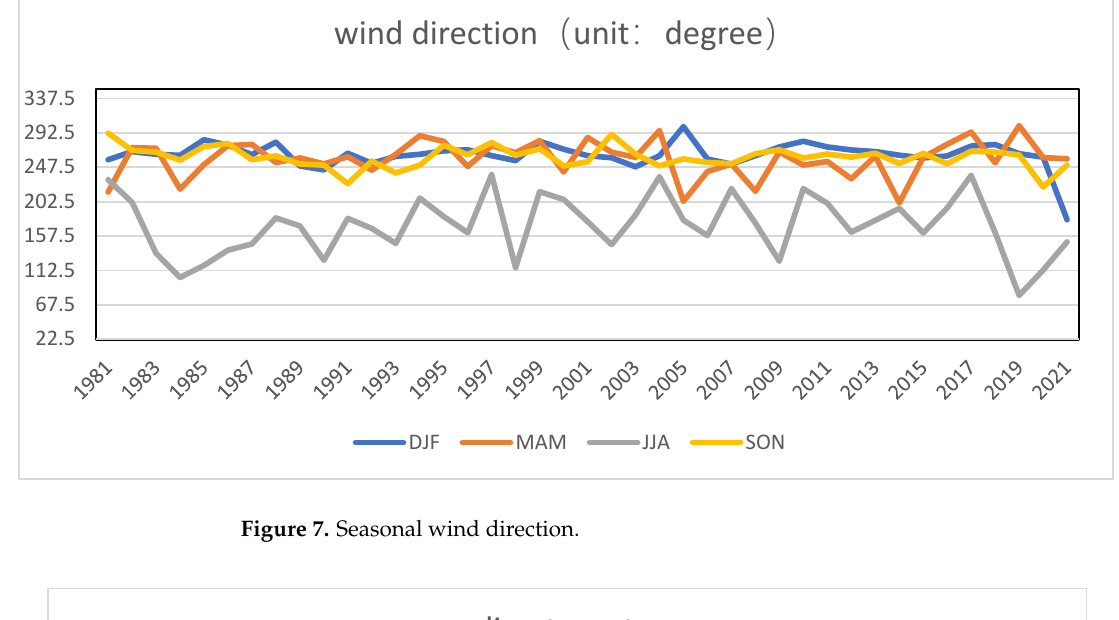
Figure 7. Seasonal wind direction.